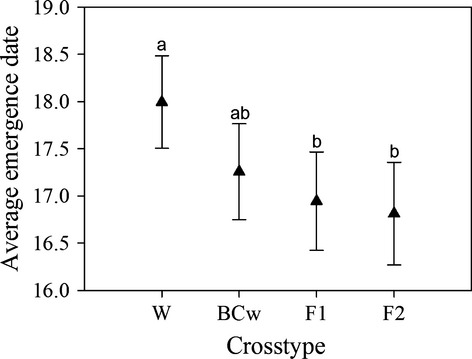
Observed differences in average emergence date for W, BCw, F1, and F2 sunflower crop–wild hybrid cross types originating from our experiment in Jefferson County, Kansas; n = 2670. Values are means ± 1 SE. Cross types that are marked with the same letter are not significantly different at the 0.05 level using a Tukey–Kramer adjustment for multiple comparisons.